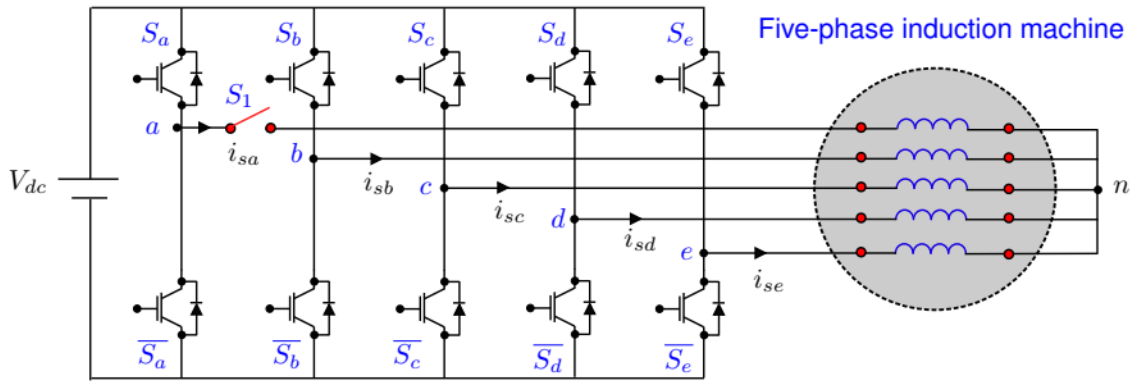
Figure 1. Five-phase drive system with single-phase opened.